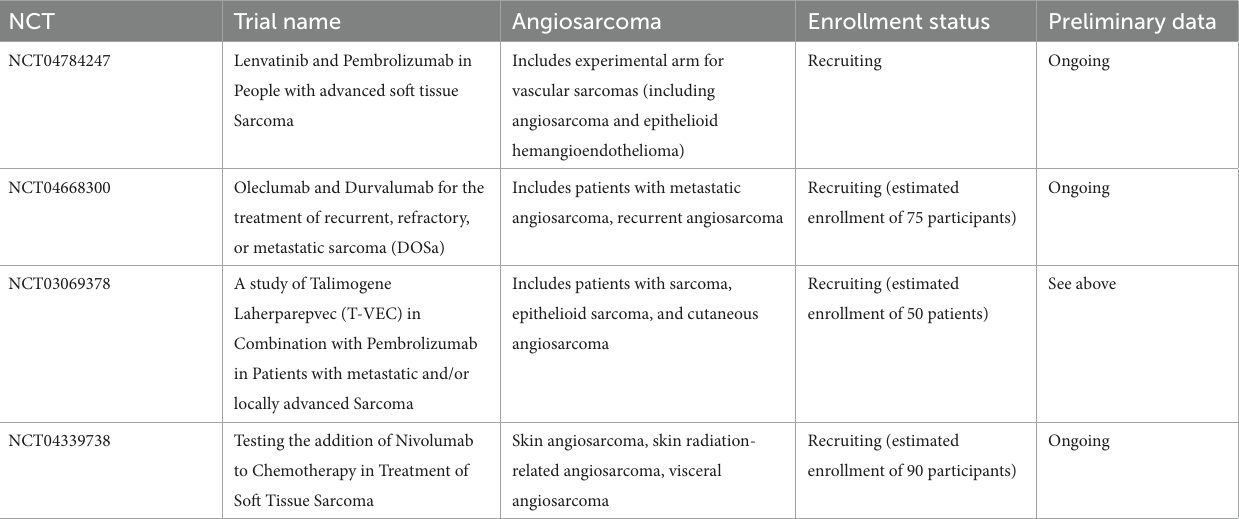
TABLE 2 Ongoing clinical